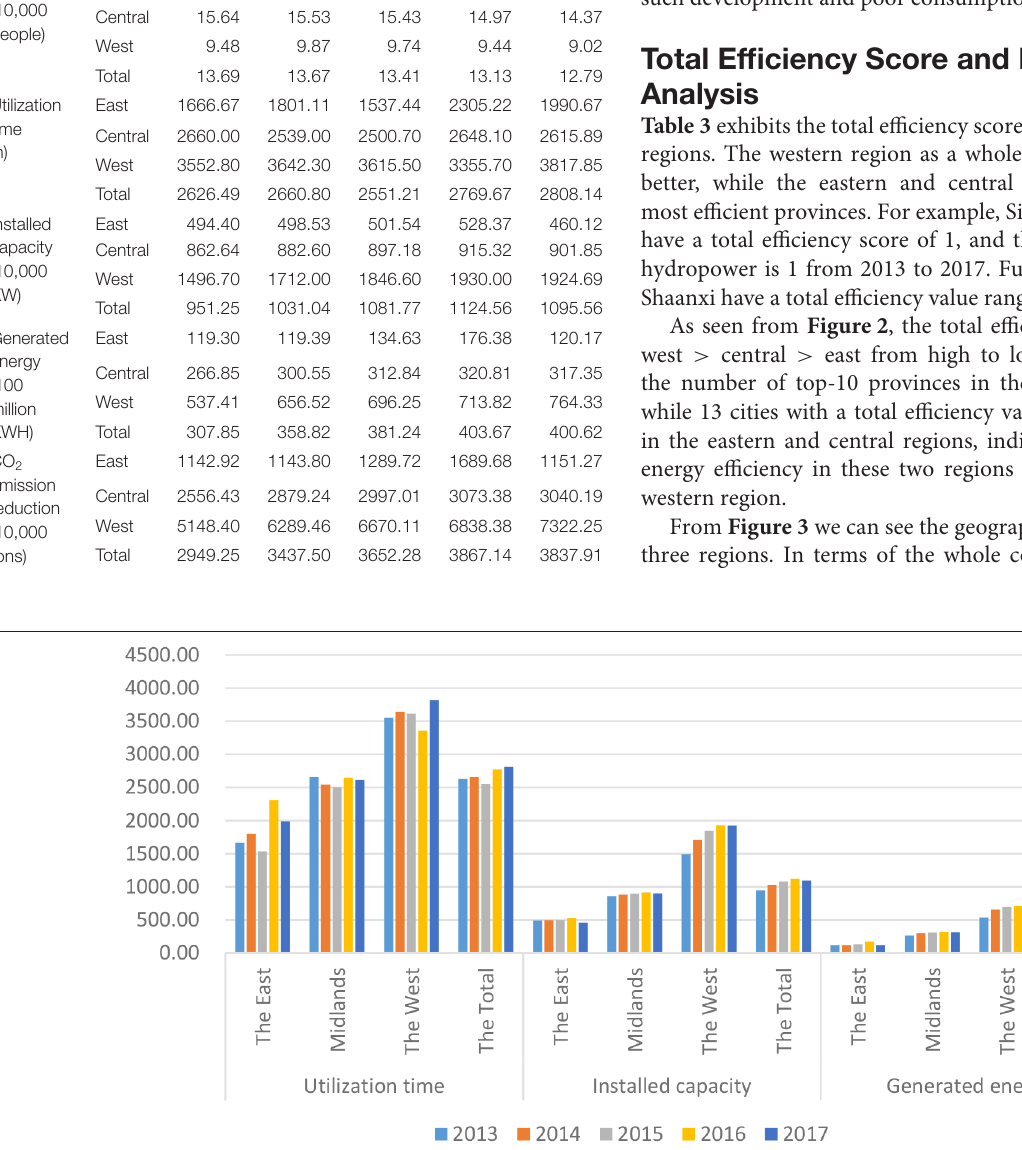
Frontiers in Energy Research |